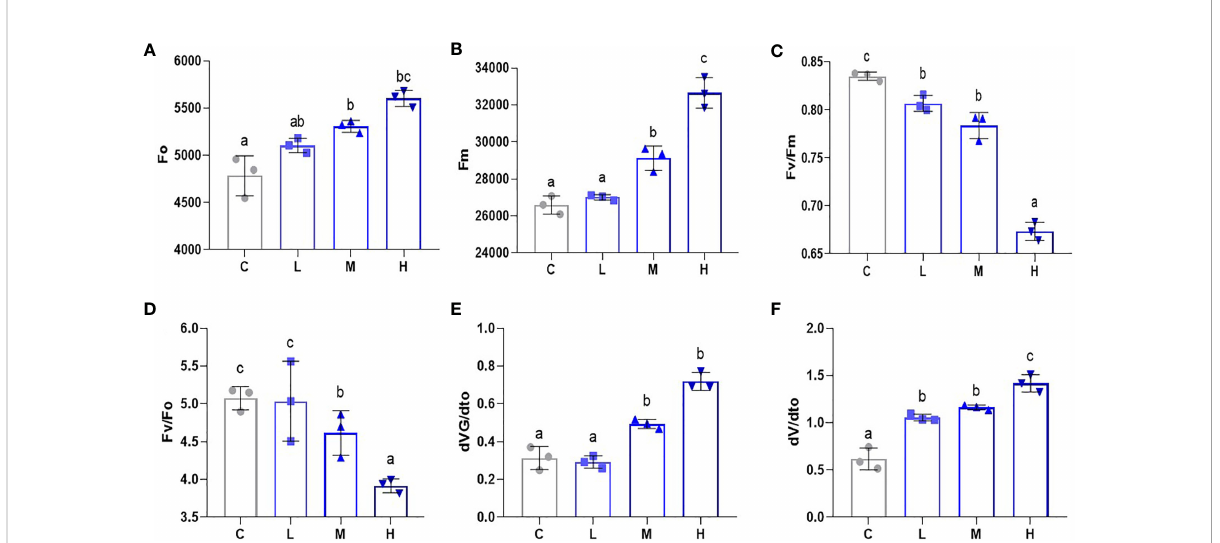
FIGURE 5 Pb stress has a dose-dependent effect on the PSII response system of pakchoi. (A) The initial fl uorescence (Fo) of Pb stress pakchoi (44 d) (n=3). (B) The maximum fl uorescence (Fm) of Pb stress pakchoi (44 d) (n=3). (C) The maximum photochemical ef fi ciency of PSII (Fv/Fm) in pakchoi leaves (44 d) (n=3). (D) The potential of PSII Photochemical activity (Fv/Fo) in pakchoi leaves (44 d) (n=3). (E) The 100 m s photoreaction center closed puri fi cation rate (dVG/dto) in pakchoi leaves (44 d) (n=3). (F) The 300 m s photoreaction center closed puri fi cation rate (dV/dto) in pakchoi leaves (44 d) (n=3). The same letter indicates no signi fi cant difference (P > 0.05); completely different letter indicates signi fi cant difference (P <